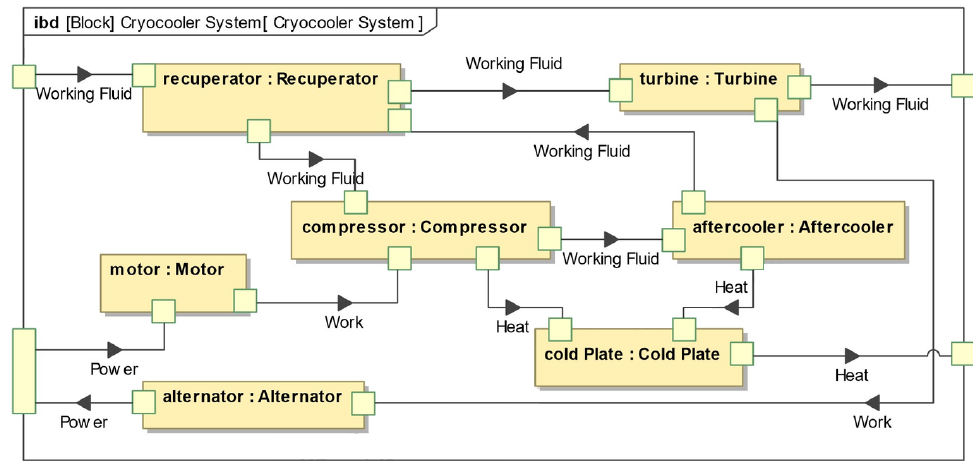
Figure 17. Cryocooler system